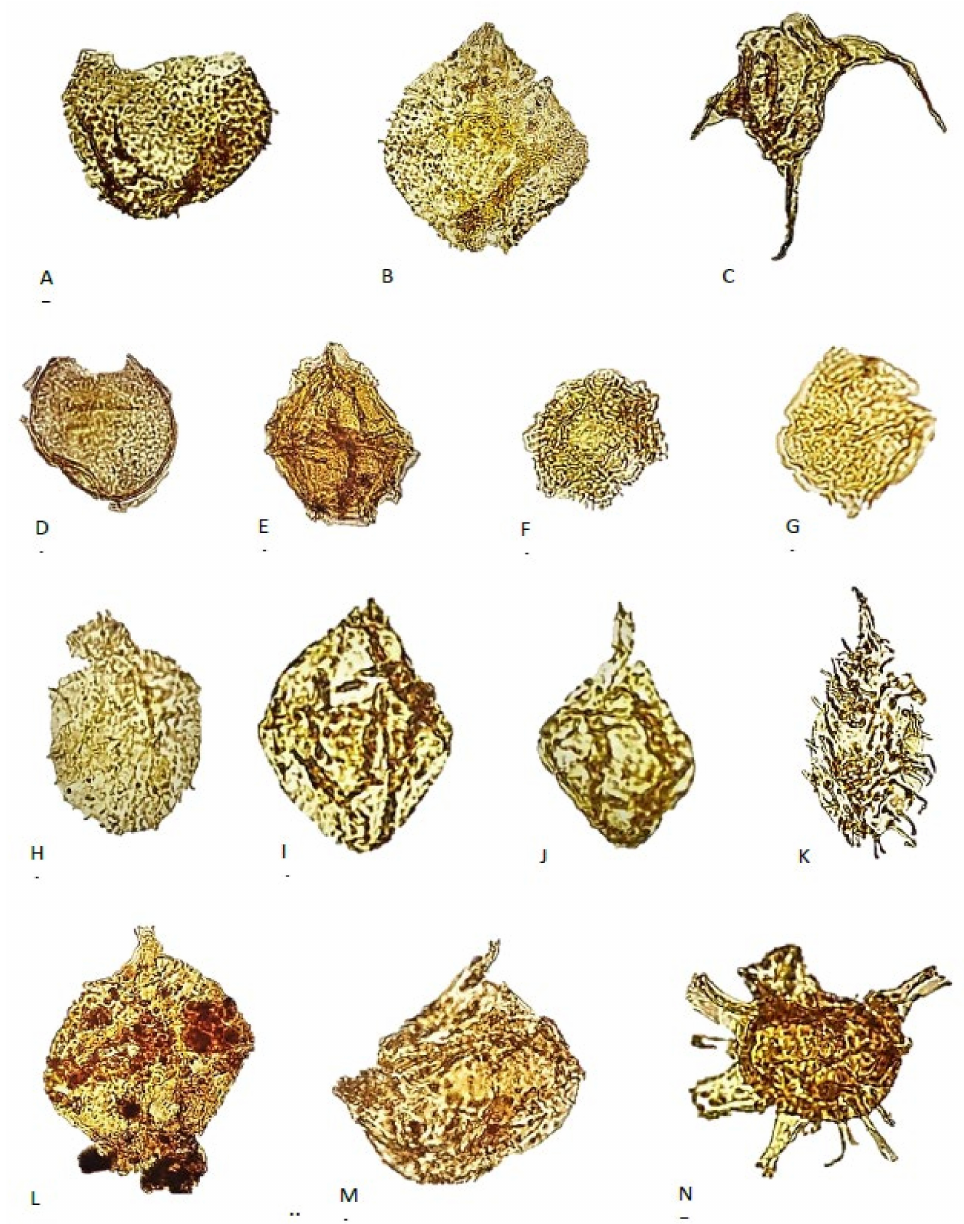
Figure 9. Dinoflagellate cysts from boreholes Bh 1, Bh 2 and Bh 3. ( A ) Circulodinium distinctum , Bh 2, 100.8 m (6), width 85 µ m. ( B ) Circulodinium distinctum , Bh 2, 25.0 m (5), width 91 µ m. ( C ) Muderongia tetracantha , Bh 2, 115.1 m (4), width 82 µ m. ( D ) Ambonosphaera? staffinensis , Bh 1, 22.23 m (7), width 55 µ m. ( E ) Gonyaulacysta helicoidea , Bh 2, 25.0 m (6), width 53 µ m. ( F ) Chlamydophorella nyei , Bh 2, 25.0 m (5), width 50 µ m. ( G ) Dingodinium ? sp., 196.95 m (6), width 54 µ m. ( H ) Epiplosphaera gochtii , Bh 3, 68.7 m (6), width 60 µ m. ( I ) Criborperidinium sp., Bh 2, 72.6 m (7), width 56 µ m. ( J ) Pareodinia ceratophora , Bh 2, 177.05 m (6), width 52 µ m. ( K ) Gochteodinia villosa , Bh 2, 153.2 m (6), body width 55 µ m. ( L ) Cribroperidinium sp., Bh 3, 44.45 m (2), width 67 µ m. ( M ) Cribroperidinium sp., Bh 3, 44.45 m (2), width 75 µ m. ( N ) Kleithriasphaeridium corrugatum , Bh 2, 25.0 m (6), width central body 56 µ